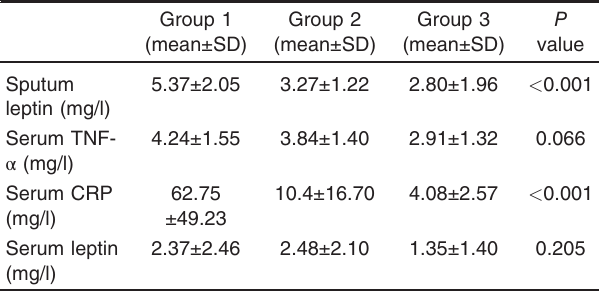
Table 2 Statistical comparison among the study groups regarding mean values of sputum leptin, serum tumor necrosis factor- α , C-reactive protein, and leptin level